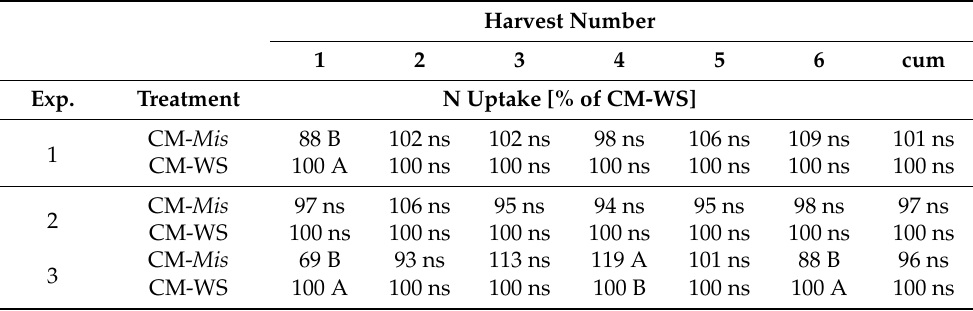
Table 8. Percentage of the new type of cattle manure from Miscanthus shredded bedding (CM- Mis ) to N uptake of conventional cattle manure from wheat straw bedding (CM-WS), at the time of each harvest and cumulatively (cum). Listed for experiment (exp.) 1, 2 and 3, respectively. Different letters within a column and within each experiment number show significant differences between the two types of manure ( p < 0.05, t -test); ns = not significant; n = 5.